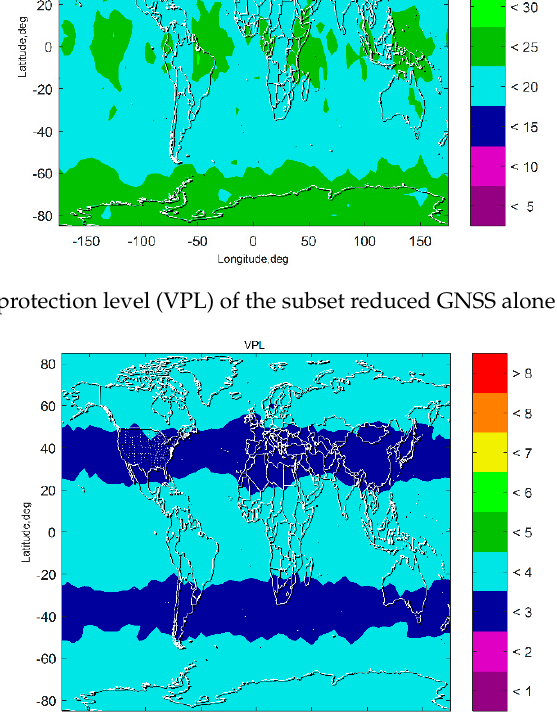
Figure 8. VPL of the subset reduced GNSS / INS FD only ARAIM.